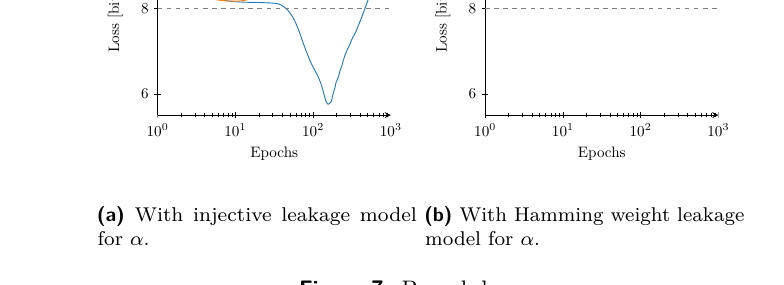
Figure 7: Branch